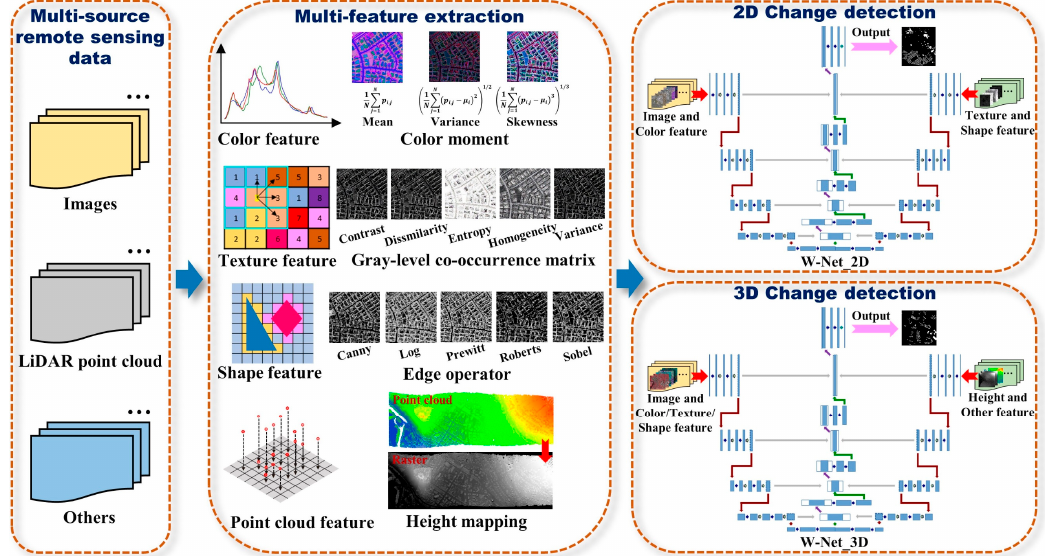
Figure 1. Overview of the 2D/3D building change detection (BCD) architecture based on the Squeeze-and-Excitation W-Net.